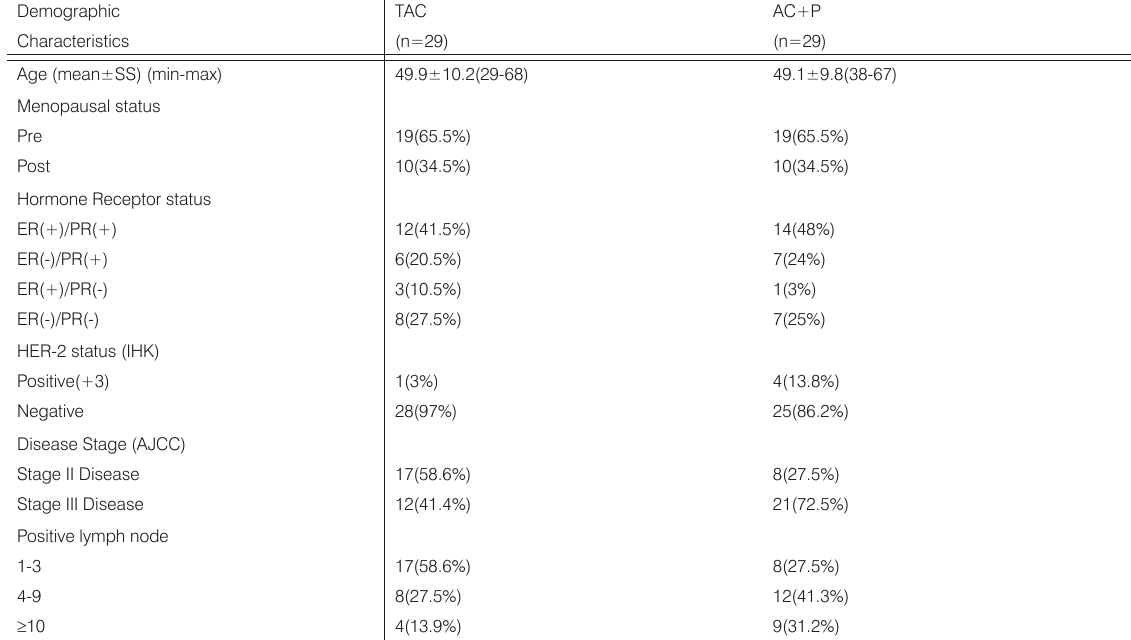
Table 1. Demographic characteristics of patients.